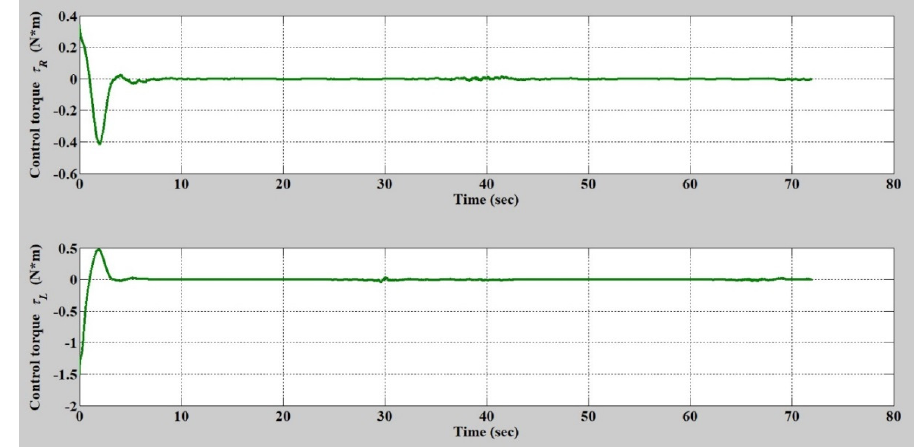
Figure 9. Results of circular trajectory tracking torques concerning initial point ( x c = 0 m, y c = 1.9 m).